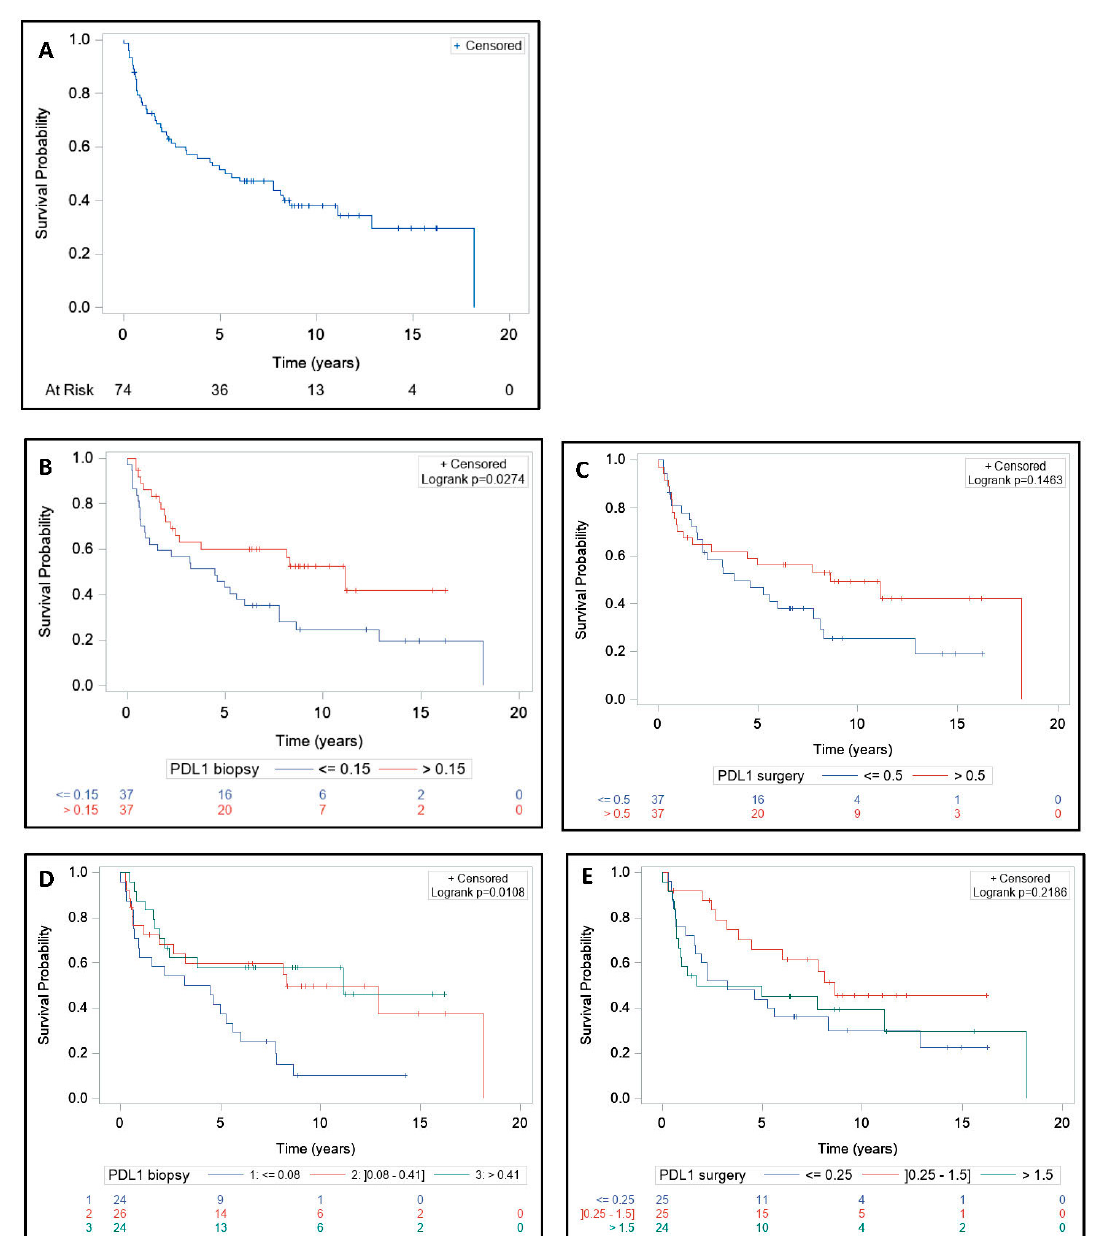
Figure 3. Impact of PD-L1 expression on progression-free survival before and after treatment. Patients ( n = 74) were treated with neoadjuvant short-course radiotherapy or long-course concurrent chemoradiotherapy followed by surgery. Biopsies and surgical specimens were collected and PD-L1 expression was retrospectively detected by immunohistochemistry using the monoclonal QR1 anti-PD-L1 antibody (Diagomics). The expression of PD-L1 on cell membranes and cytoplasms was automatically quantified by scripts using the software QuPath based on the percentage of stained cells (total tumor and stromal cells) in three regions per slide. The progression-free survival (PFS) in the entire cohort ( A ); PFS according to median PD-L1 + cells rate on biopsies ( B ); PFS according to median PD-L1 + cells rate on surgical specimens ( C ); PFS according to first, second, and third terciles on biopsies ( D ); and PFS according to first, second, and third terciles on surgical specimens ( E ). PFS curves were estimated using the Kaplan–Meier method. The log-rank test was used to compare survival curves.